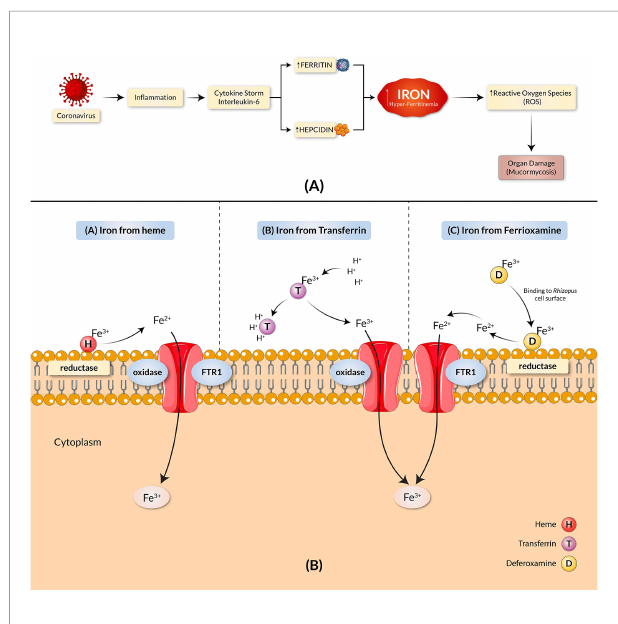
FIGURE 1 | COVID-19 and mucormycosis correlated through the iron uptake mechanism. (A) Irondysregulation and COVID-19. SARS-CoV-2 causes heightened in fl ammation anda pro-in fl ammatory cytokine storm, elevating hepcidinsynthesis. The increase in hepcidinreduces the availableFerroportin and leadsto intracellular iron overload,causingan increase in ferritin concentration. The result ishyper-ferritinemia. (B) Proposed pathogenic mechanisms of mucormycosis through ironuptake include the stripping offerric ions(Fe3+) from heme groups (H),proton-mediated displacement offerricions fromtransferrin(T), andchelation offerricirons bydeferoxamine (D).The copper oxidase – iron permease (FTR1) complex transports ironacross the cellmembranein